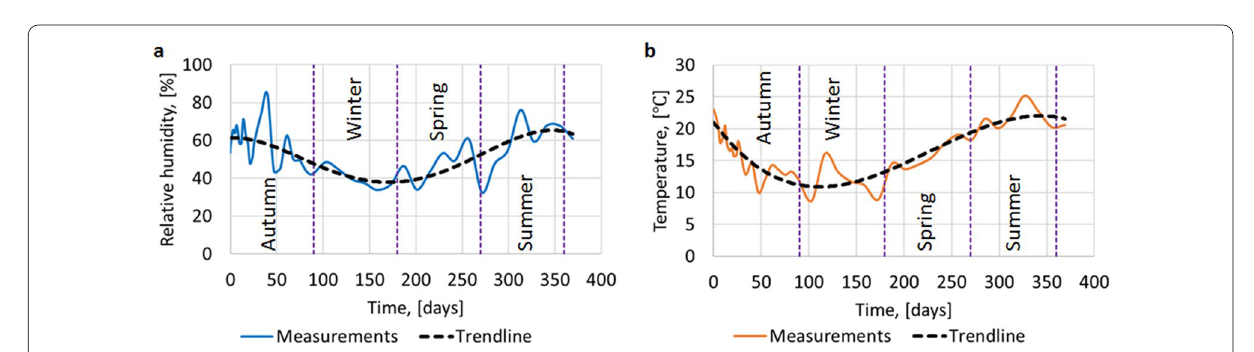
Fig. 3 Environmental conditions: a relative humidity, b temperature.